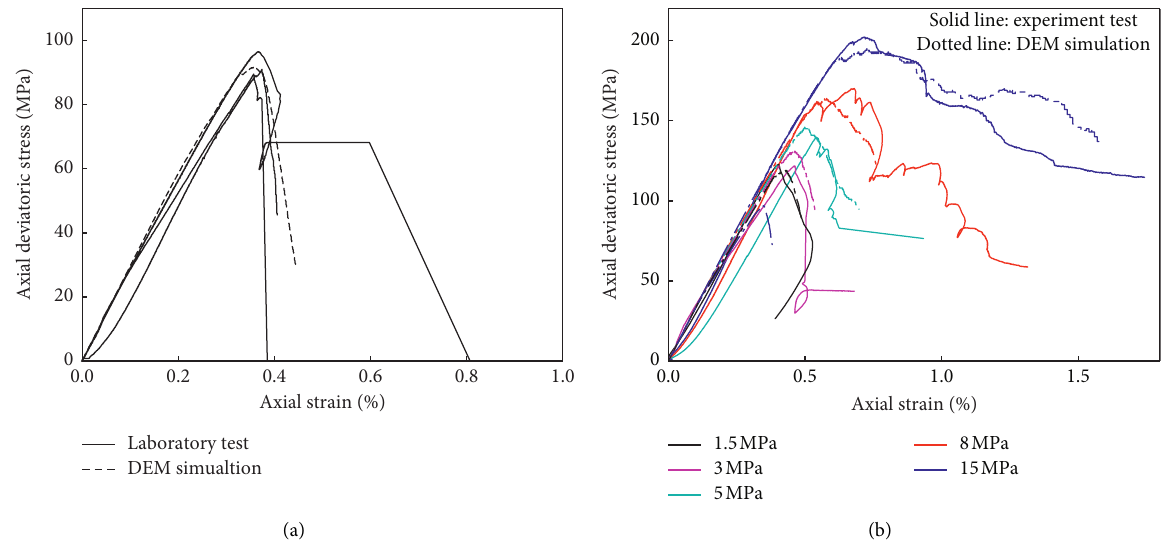
Figure 6: Stress-strain curves obtained from the laboratory and numerical tests. (a) Uniaxial compressive stress-strain curves. (b) Confining compressive stress-strain curves.